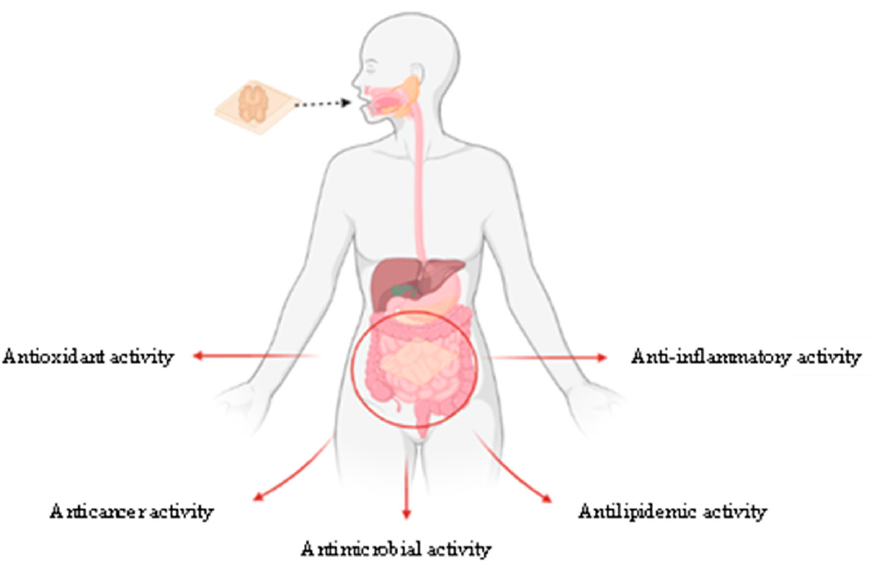
Figure 4. Overview of possible beneficial health effects of bioactive edible films containing curcumin. Table 1. Primary effects of curcumin incorporation on the properties of edible bioactive biopoly- meric films.